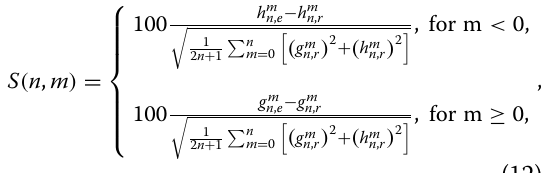
m h m where g n , k and n , k are the Gauss coefficients of model “ k ”; and the matrix of normalized coefficient differences (in %), S ( n , m )